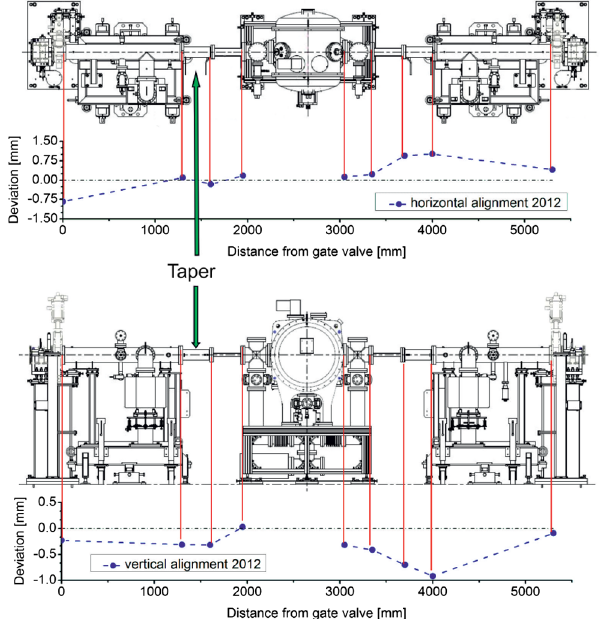
FIG. 13. Measurement of the position of the components in the COLDDIAG straight. The upper picture shows the horizontal alignment, the bottom one the vertical alignment.